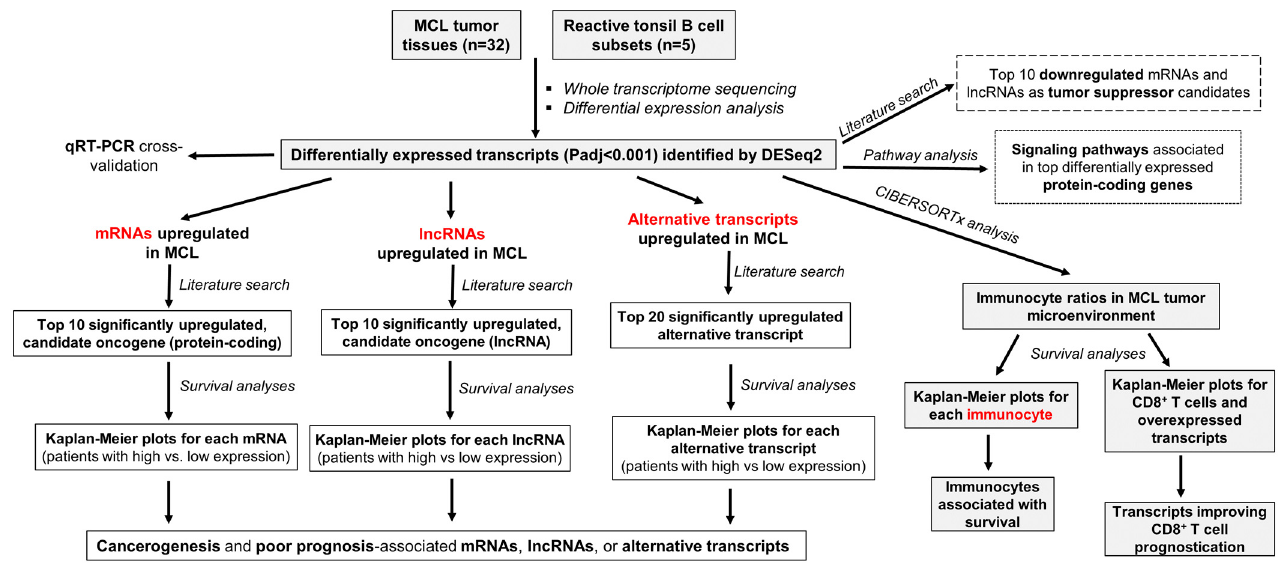
Figure 1. The overall workflow of the experiments and analyses.